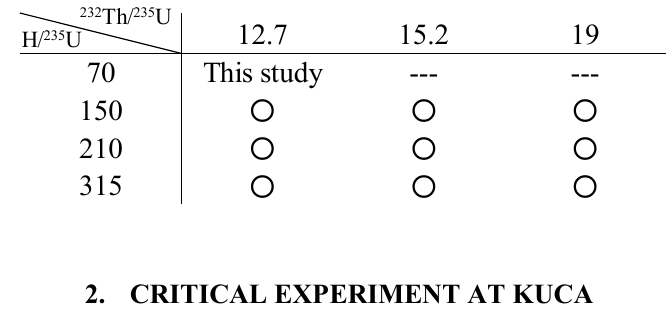
Table I. List of experiments conducted by KUCA with thorium fuel loaded core